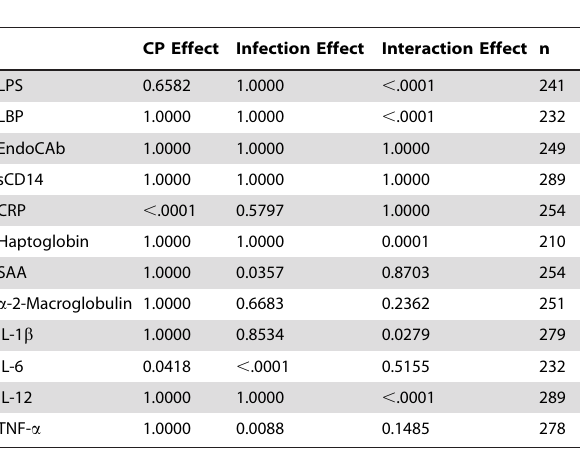
Table 2. Holm’s adjusted p-values from Linear Models, No Age Effect, n=sample size.